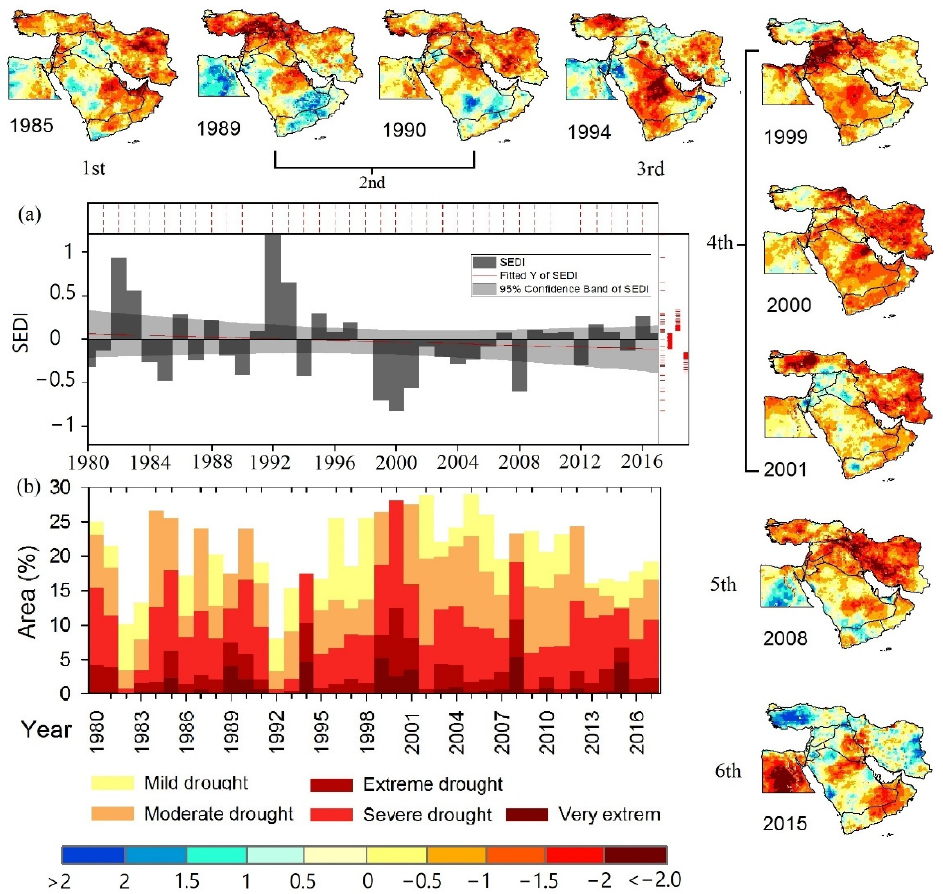
Figure 6. ( a , b ) The regional temporal trend of the SEDI and the percentage of areas affected by drought categories based on the SEDI series at an annual timescale over the Middle East between 1980 and 2017.